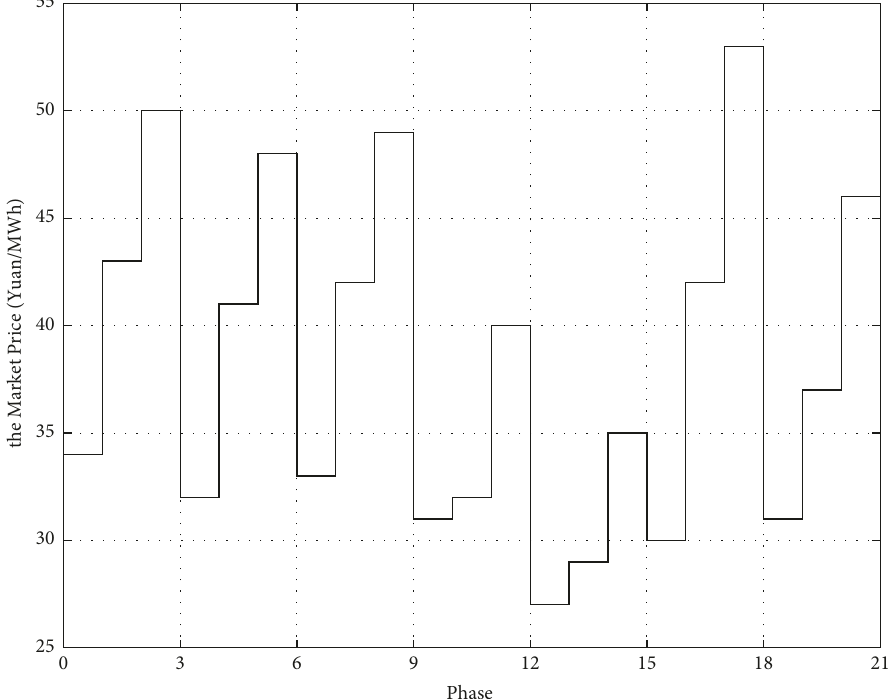
Figure 3: The market price forecast in the next